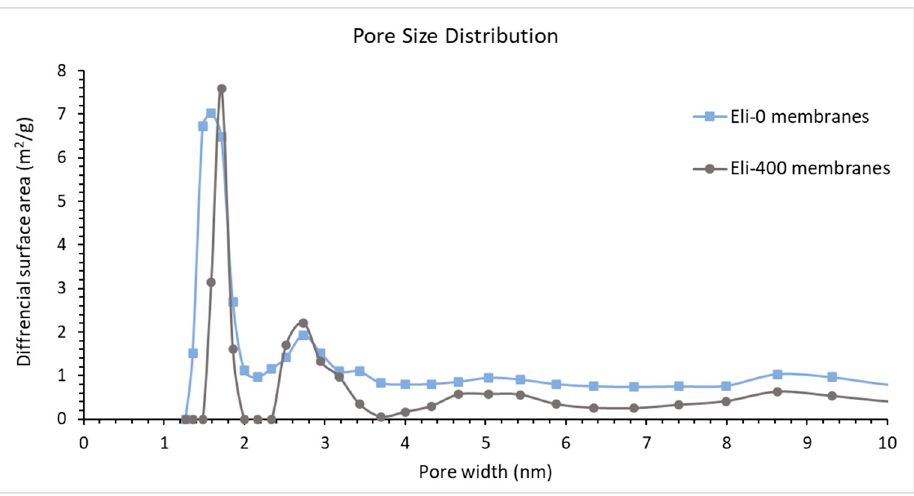
Figure 9. Differential pore areas versus pore width for the two nanocomposite membranes.